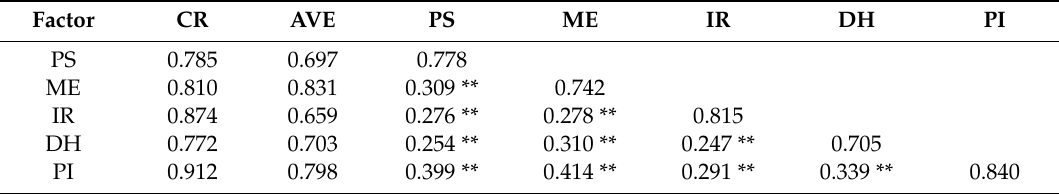
Table 5. Composite reliability, convergent and discriminant validity.